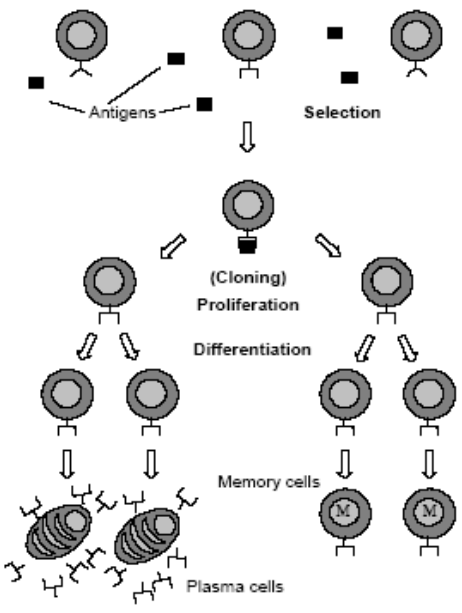
Fig. 1. The clonal selection principle 25